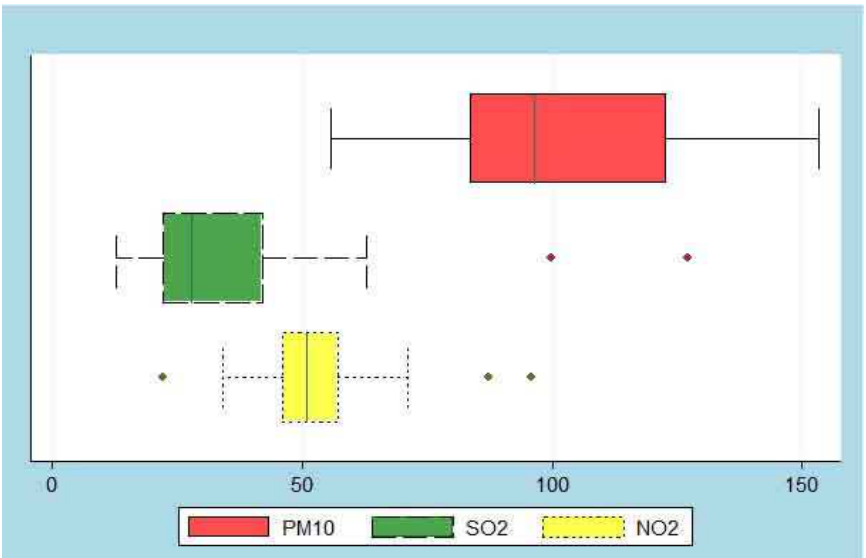
Figure 3. Box plots of the measured air pollutants [Note that particulate matter (PM10) units is in µg/m3, sulfur dioxide (SO2) and nitrogen dioxide (NO2) units are in